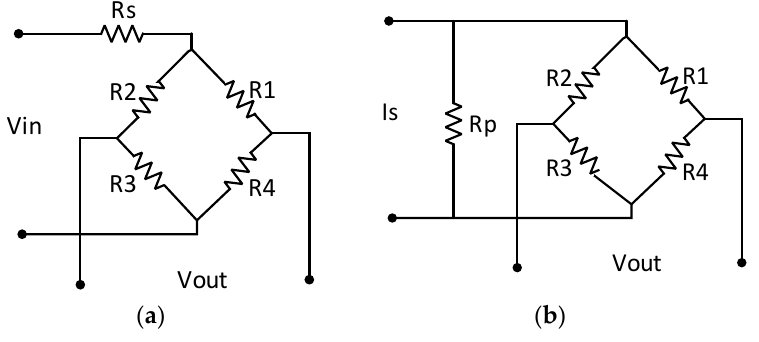
Figure 4. Compensation of the bridge sensitivity.